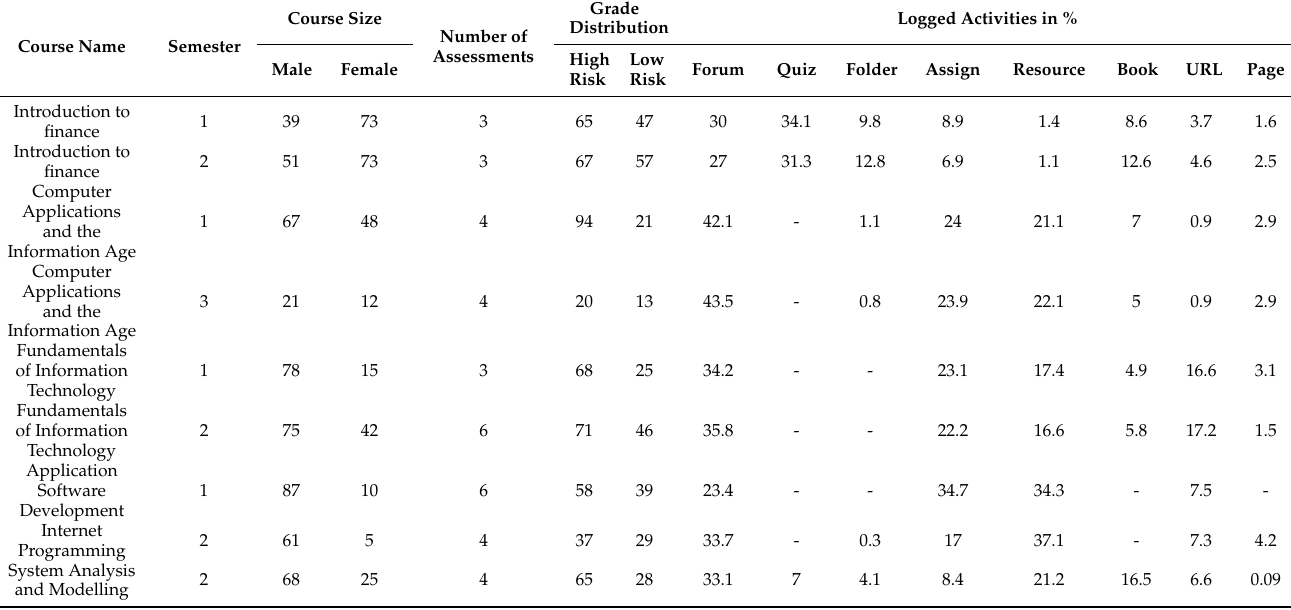
Table 2. Information about the courses and corresponding log